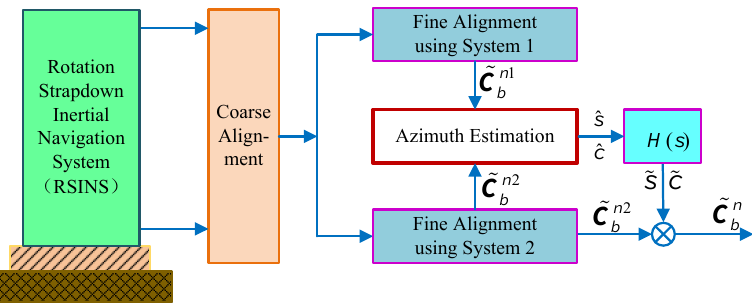
Figure 10. The schematic diagram of improved DMCS-based alignment